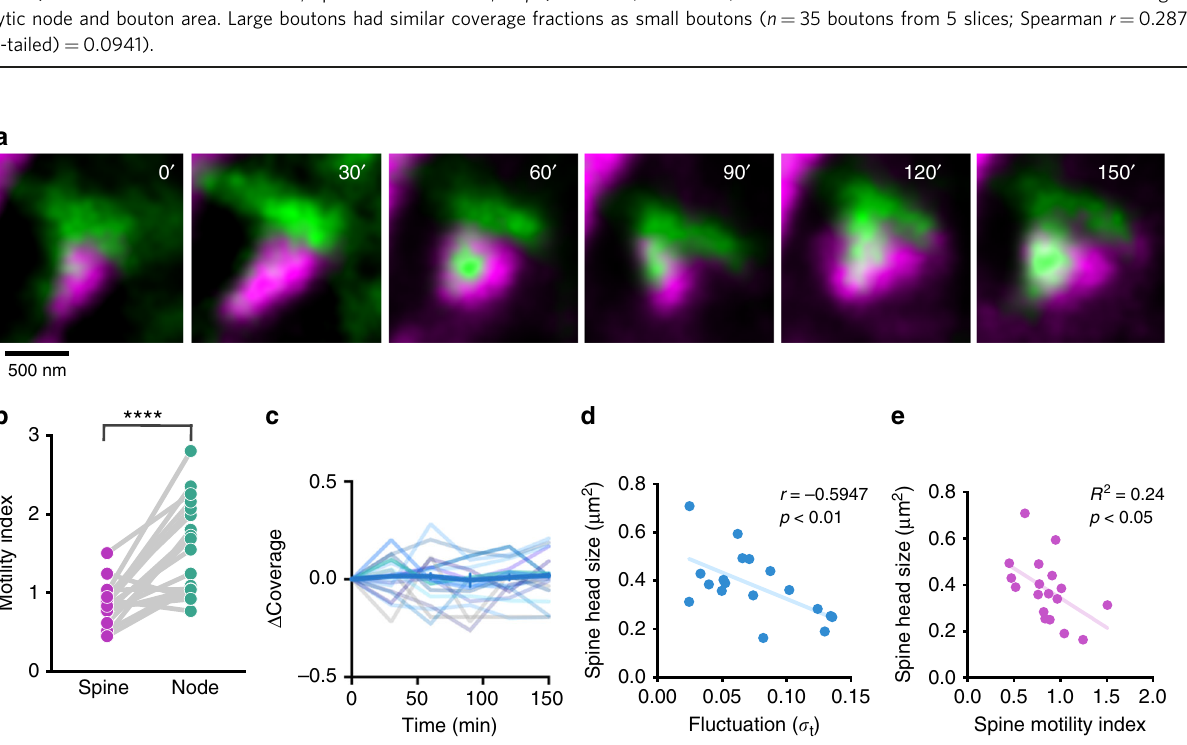
Fig. 4 Node-spine contacts are largely stable. a Time-lapse STED imaging of a spine (magenta) and a node (green) over 150 min acquired every 30 min. While contacting node can move on the spine surface, the overall contact is maintained. b Comparison between spine motility index and contacting nodes. Motility index of the node was signi fi cantly higher than that of spines ( n = 18 structures from 5 slices; Paired t -test, **** p (two-tailed) < 0.0001). c Changes of coverage state over time normalized to the coverage state at 0 min ( n = 18 spines from 5 slices). d Correlation between fl uctuation (the temporal variance of coverage fraction) and spine head area ( n = 18 spines from 5 slices; Spearman r = − 0.5947, p (two-tailed) = 0.0092. Large node/large spine contact was more stable. e Correlation between spine head size and spine motility index. Large spines were less motile than small spines ( n = 18 spines from 5 slices; Pearson R 2 = 0.24, p (two-tailed) =